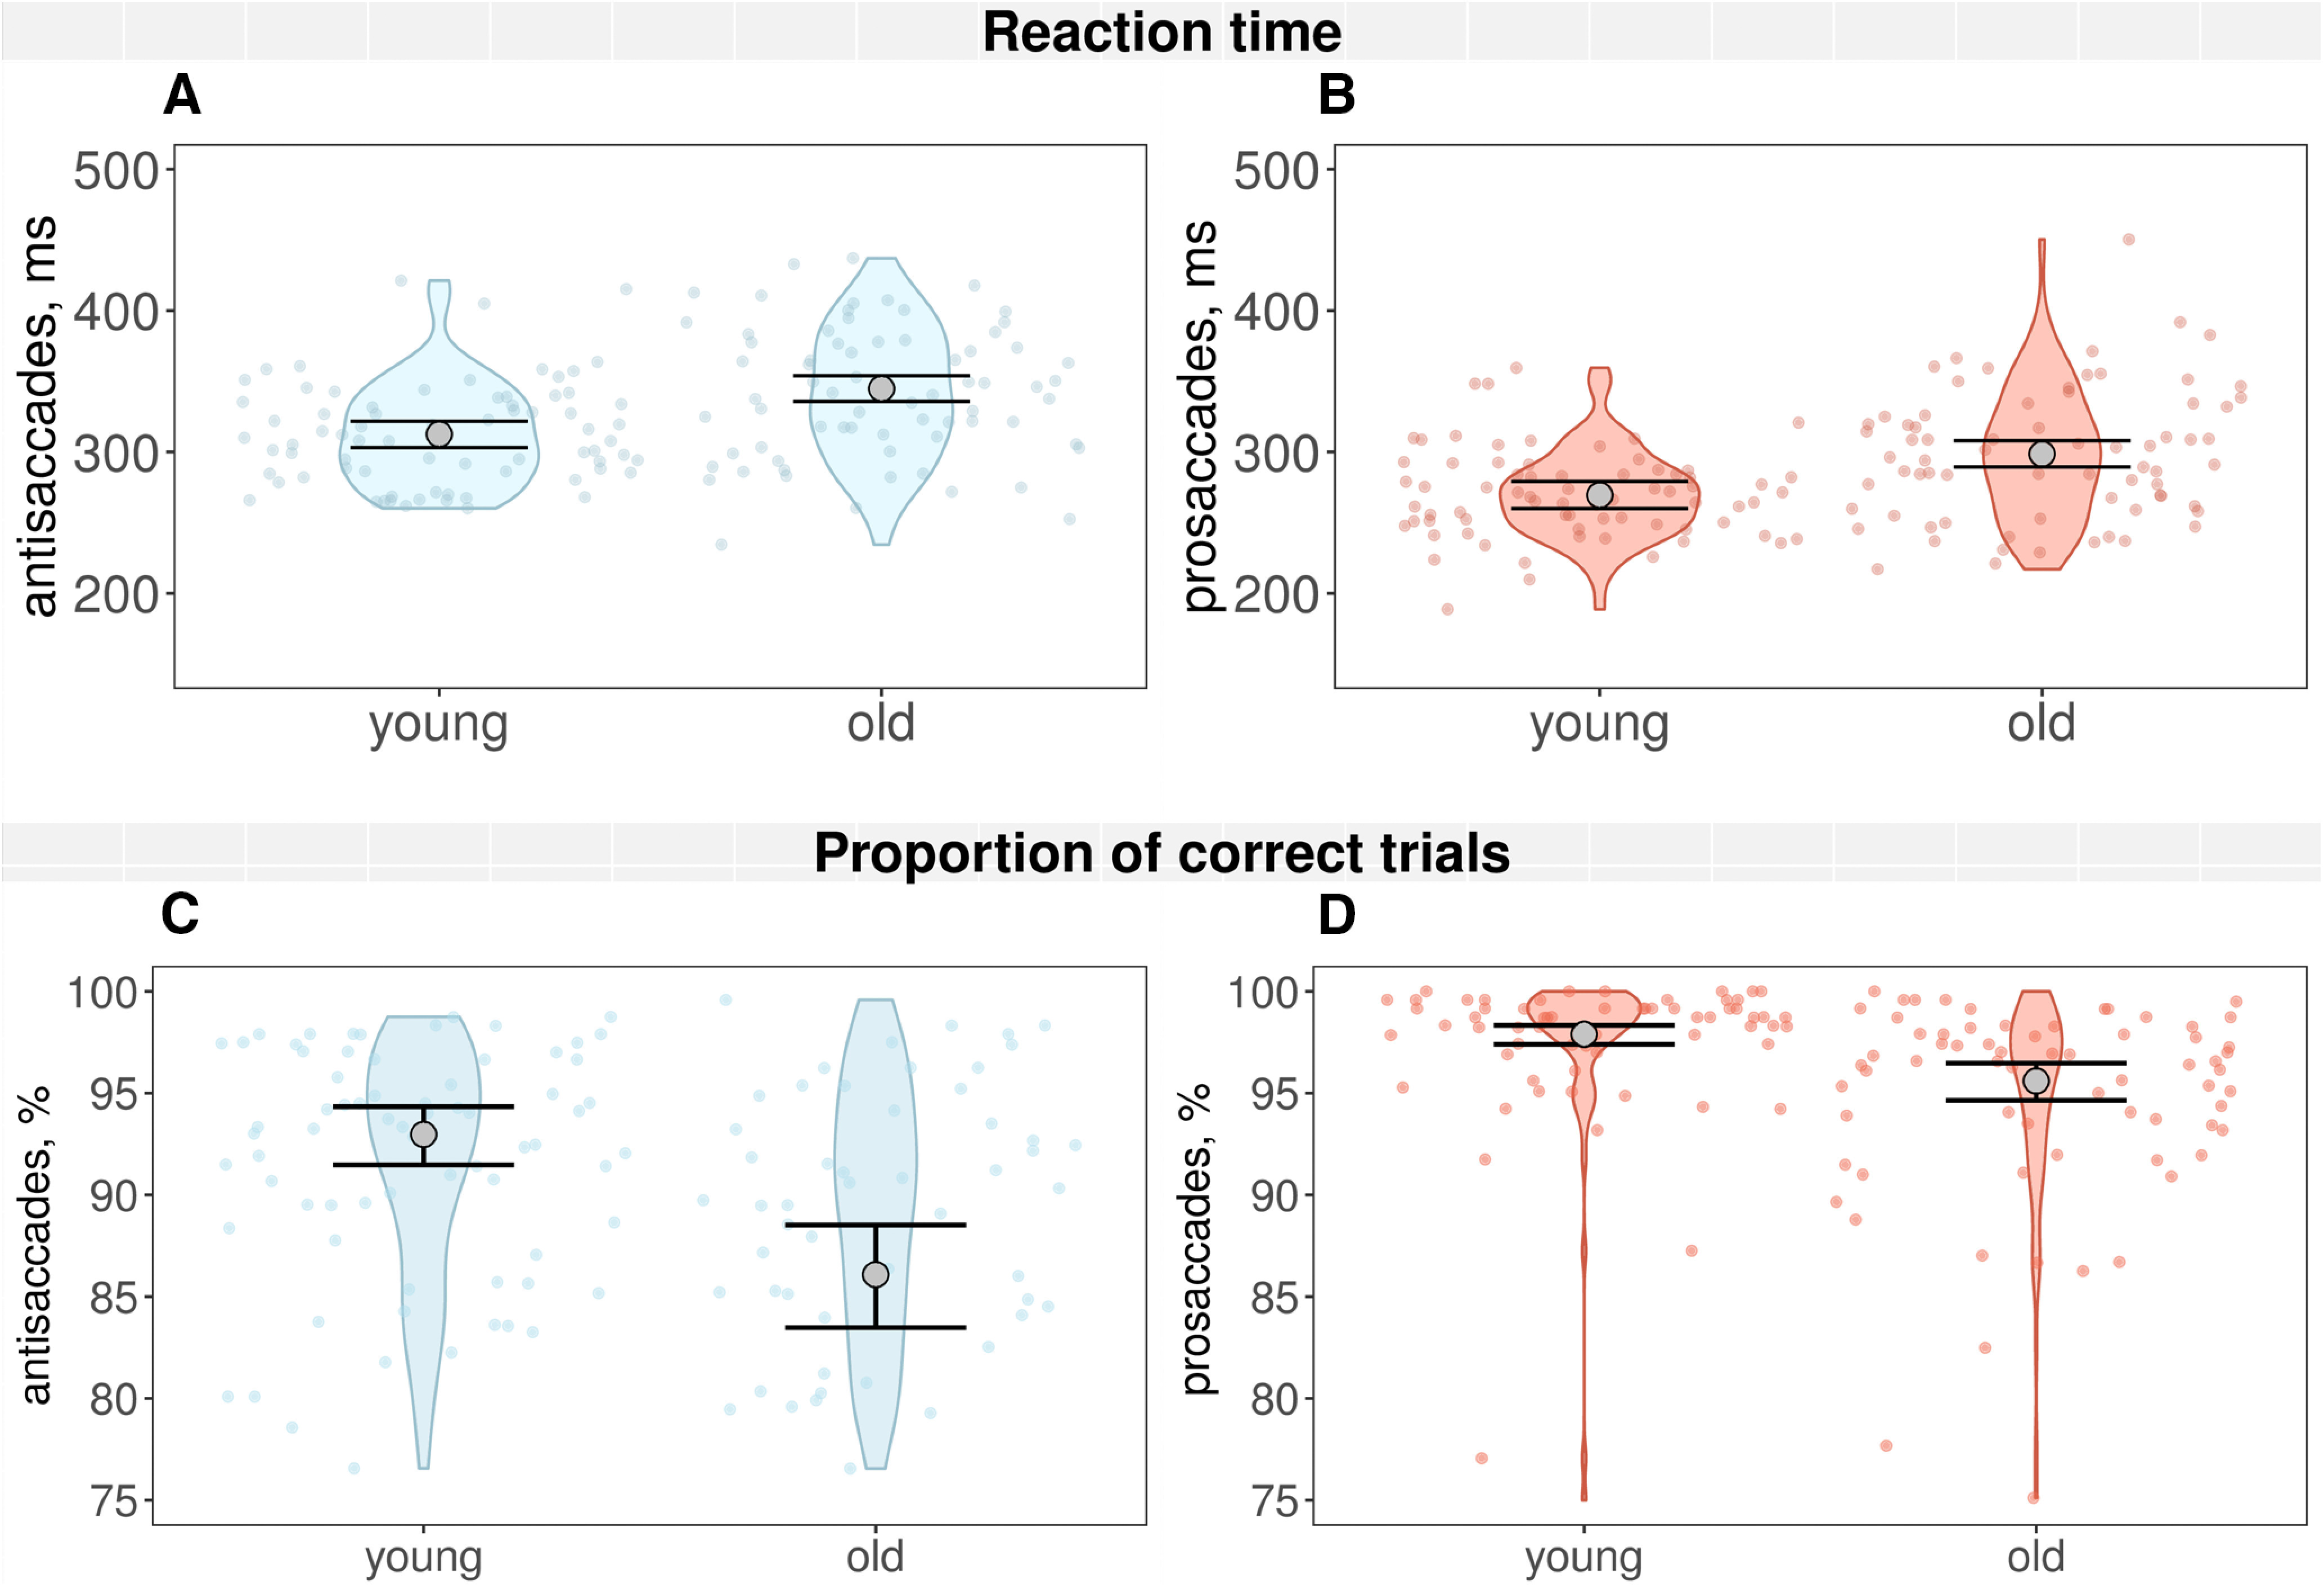
Reaction times (A, B) and proportion of correct trials (C, D); plots of the Bayesian model predictions. Large gray points show mean fitted values; the mean of posterior distribution and 98.7% CIs. Small red (prosaccades) and blue (antisaccades) dots represent means over all blocks (two for prosaccades, three for antisaccades) for all the participants.